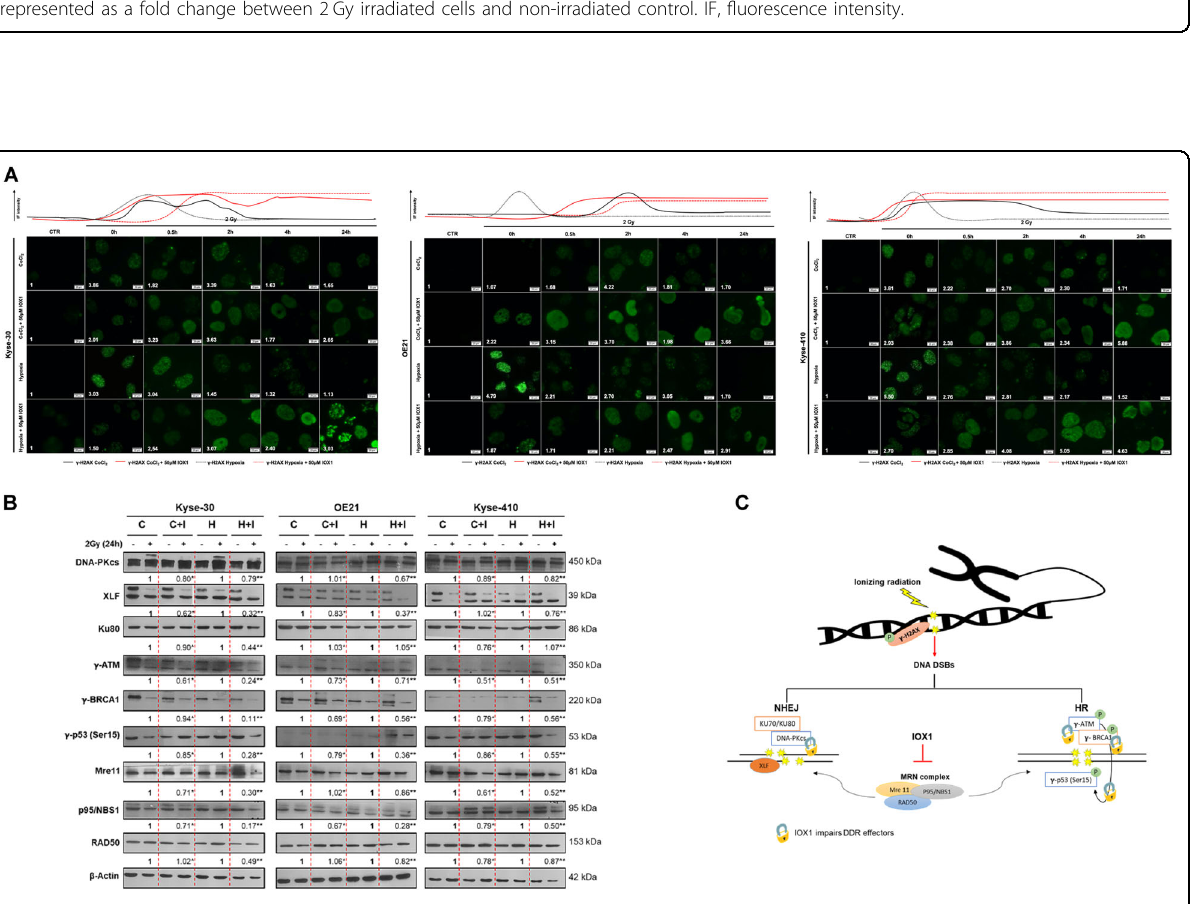
Fig. 5 Effect of IOX1 inhibitor in DNA damage repair after 2 Gy irradiation in ESCC cell lines. a Representative pictures of nuclear γ -H2AX staining of 2 Gy irradiated ESCC cells treated with 50 µM IOX1 (0 – 24 h) under 50 µM CoCl 2 and hypoxia (0.5 – 1% O 2 ) conditions. All pictures were taken from Olympus IX51 microscope at ×400 magni fi cation (scale bar 20 μ m). ImageJ software (version 1.6.1, from National Institutes of Health) was used for IF quanti fi cation and represents a fold change between 2 Gy irradiated cells and non-irradiated control. IF, fl uorescence intensity. b Representative images of total XLF (39 kDa), DNA-PKcs (450kDa), Ku80 (86 kDa), γ -ATM (350kDa), γ -BRCA1 (220kDa), γ -p53 (53 kDa), Mre11 (81 kDa), NBS1(95 kDa), RAD50 (153 kDa) protein levels in ESCC cells treated with 50 µM IOX1 under 50 µM CoCl 2 and hypoxia (0.5-1% O 2 ) conditions before and after 24 h of 2 Gy irradiation. Fold change values of 2 Gy/0 Gy IOX1 were compared with 2 Gy/0 Gy hypoxic conditions alone. β -Actin (42 kDa) was used as loading control; C - 50 µM CoCl 2 ; C + I - 50 µM CoCl 2 + 50 µM IOX1; H – hypoxia; H + I – hypoxia + 50 µM CoCl 2 . c Schematic representation of DNA damage repair network. DSB, double-strand breaks; DDR, DNA damage repair; HR, homologous recombination; NHEJ, non- homologous